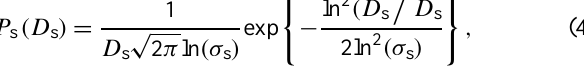
Figure 1. Mineral maps for CAM4 and AM5 based on work by Claquin et al. (1999) and Nicovic et al. (2011). Illite (a) , kaolinite (b) and montmorillonite (c) are clay-sized (0–2µm). Hematite (d) has the same distribution for both clay-sized and silt- sized (2–20µm). Quartz (e) , calcite (f) , feldspar (g) , gypsum (h) and other coarse (i) are silt-sized. CAM4 includes illite (a) , kaolinite (b) , montmorillonite (c) , hematite (d) , quartz (e) , calcite (f) , feldspar (g) and gypsum (h) . CAM5 includes illite (a) , kaolinite (b) , montmoril- lonite (c) , hematite (d) and other coarse (i) , which represents quartz, calcite, feldspar and